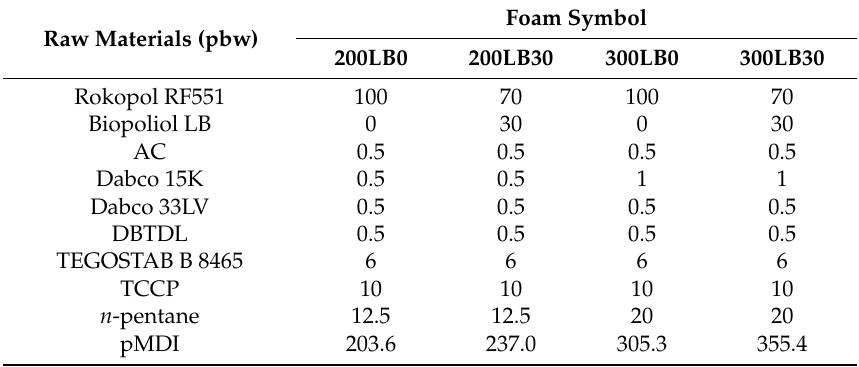
Table 2. The compositions of rigid polyurethane